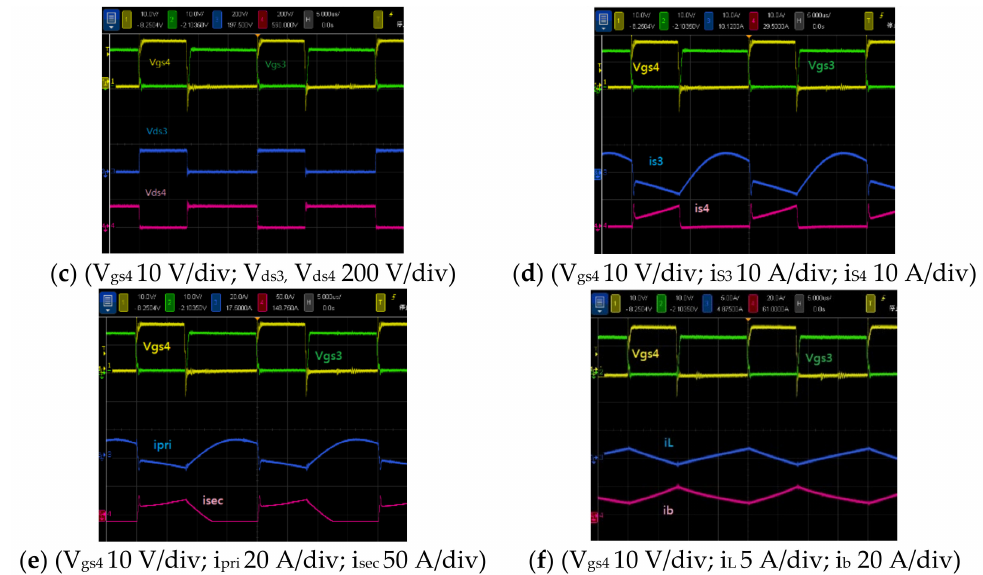
Figure 17. Measured results under Stage 3 at 500 W: ( a , b ) switch S 1 waveforms, ( c , d ) switches S 3 and S 4 waveforms, and ( e , f ) current waveforms of transformers and inductors,